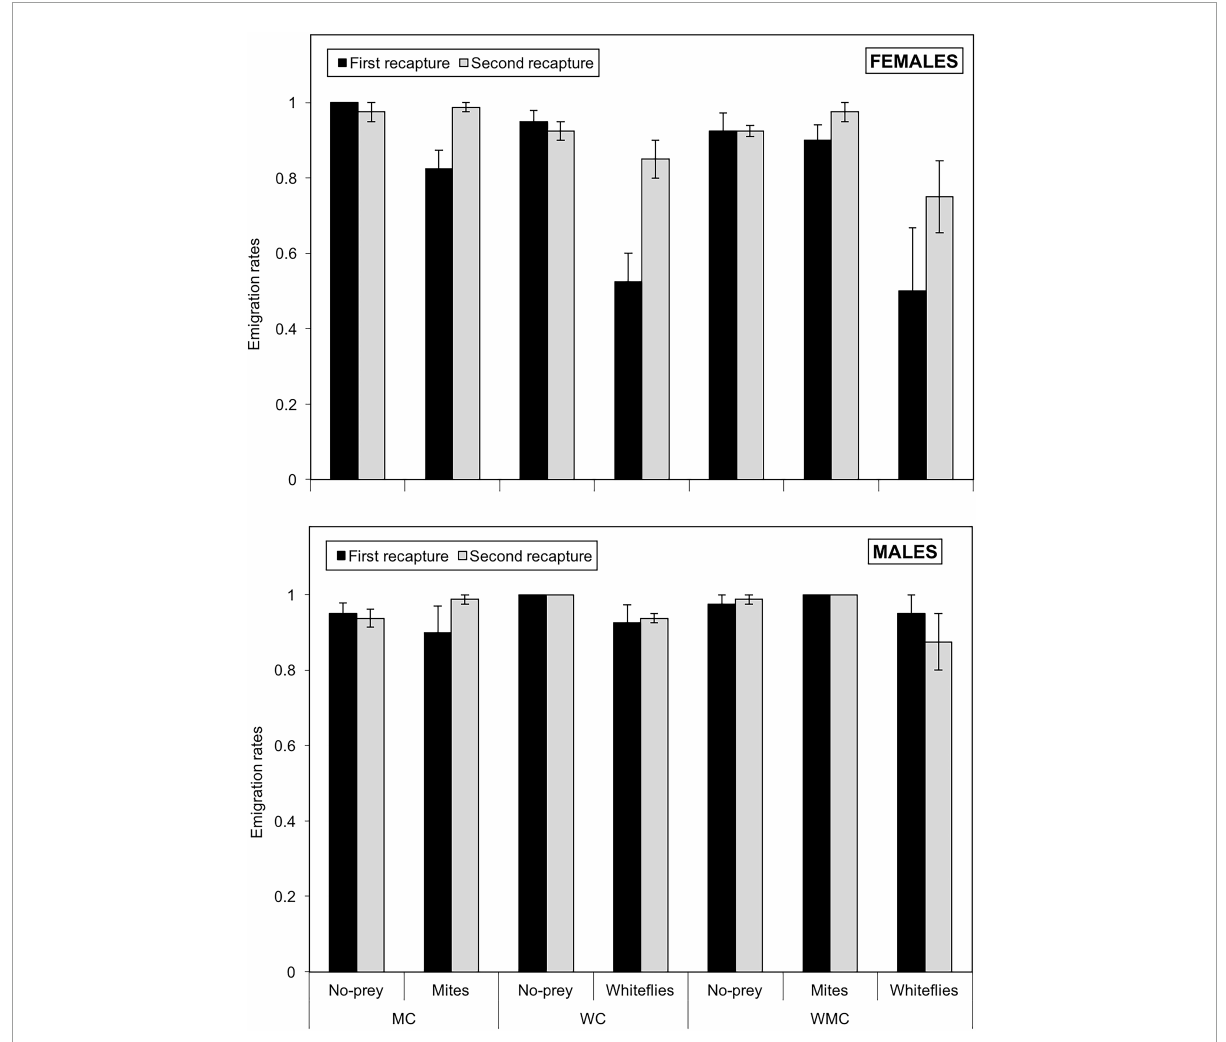
FIGURE5 Emigration rates of females (upper graph) and males (lower graph) of D. hesperus per plant with standard errors, in three habitats (MC, WC, and WMC) composed by patches with different food resources (No prey- C-, mites- M-,